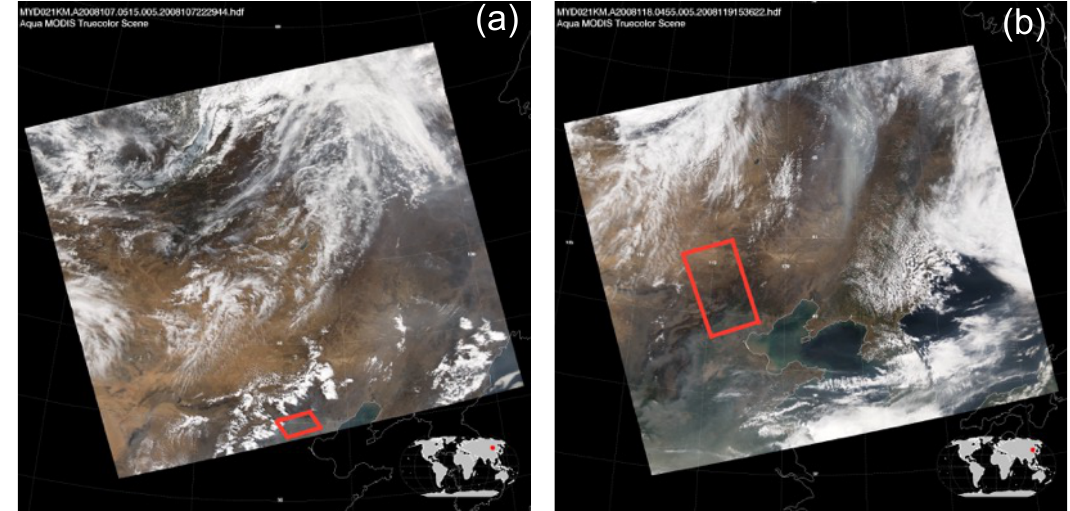
Figure 1. True-colour MODIS image (RGB) on 16 April 2008 at 05:15UTC (a) and on 27 April 2008 at 04:55UTC (b) over the Beijing area. MODIS, on the Aqua satellite, has the equator crossing time at only about 15min earlier than OMI. The area of analysed OMI pixels is marked with red contours.